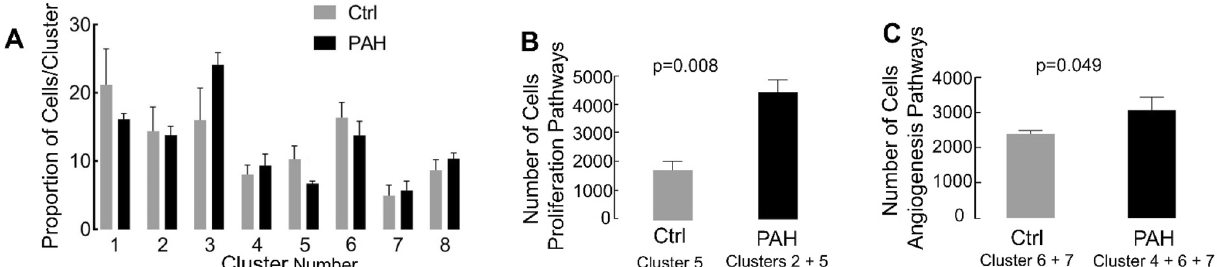
Figure 6. Increased angioproliferative cells in PAH. The mean frequency of each cluster, calculated based on the cluster frequency in the individual samples, was similar between control and PAH ( A ). The total number of cells in the clusters enriched in proliferation pathways (cluster 2 in control, and clusters 2 and 3 in PAH), was significantly increased in PAH ( B ). The total number of cells in clusters enriched in angiogenic pathways (clusters 6 and 7 in control, and clusters 5, 6, and 7 in PAH), was significantly higher in PAH ( C